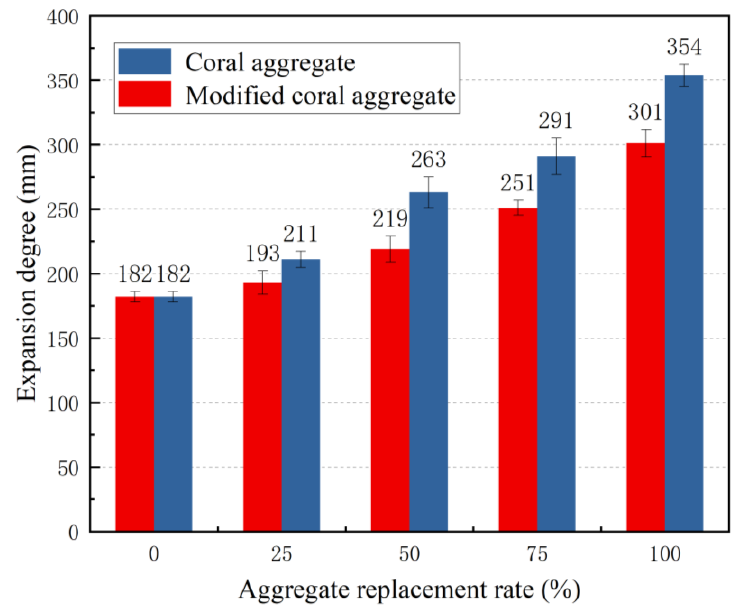
Figure 11. Relationship between aggregate replacement rate and expansion degree.